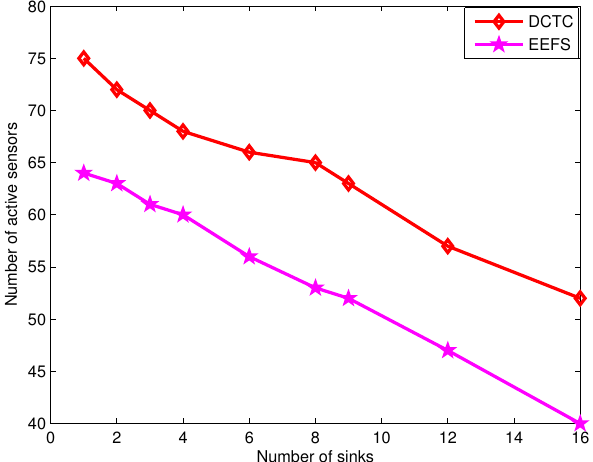
Figure 12. The number of connected cover sets vs. the number of sinks.